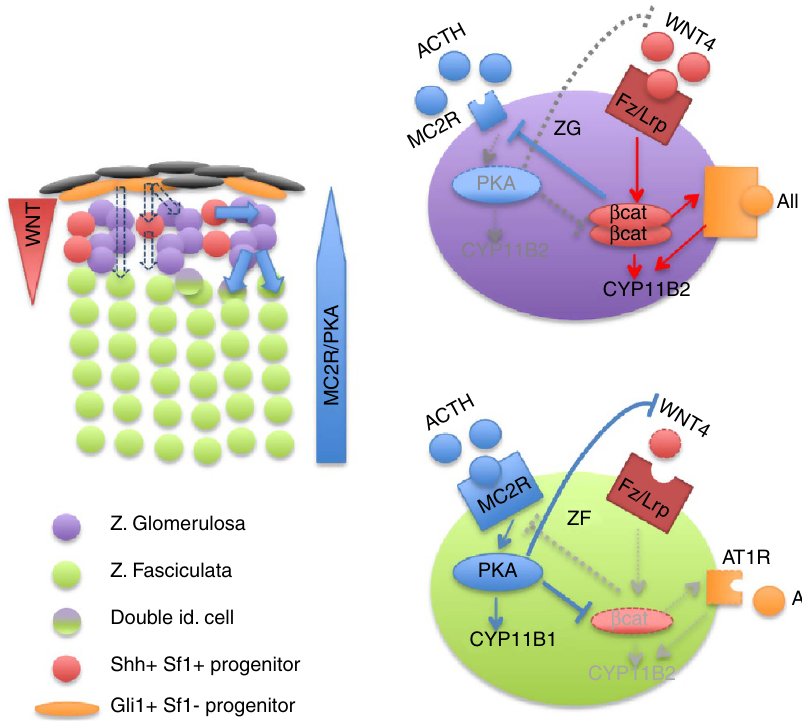
Figure 7 | Model for adrenocortical zonal differentiation. Left panel shows the zonal organization of the adrenal cortex with capsular (orange) and subcapsular (red) progenitor cells, ZG cells (purple), ZF cells (green) and transiting cells with double identity (purple and green). Solid blue arrows show the normal process of cell renewal occurring through recruitment of Shh-positive progenitors that initially differentiate as ZG cells and subsequently differentiate as ZF cells as they migrate within the cortex. Dashed arrows show alternative renewal pathways relying on capsular (Shh-negative) progenitors. Right panels show the interplay between WNTand PKA signalling pathways in ZG cells (purple) and ZF cells (green). Red arrows: activation; blue arrows: inhibition; grey arrows: inactive pathway.